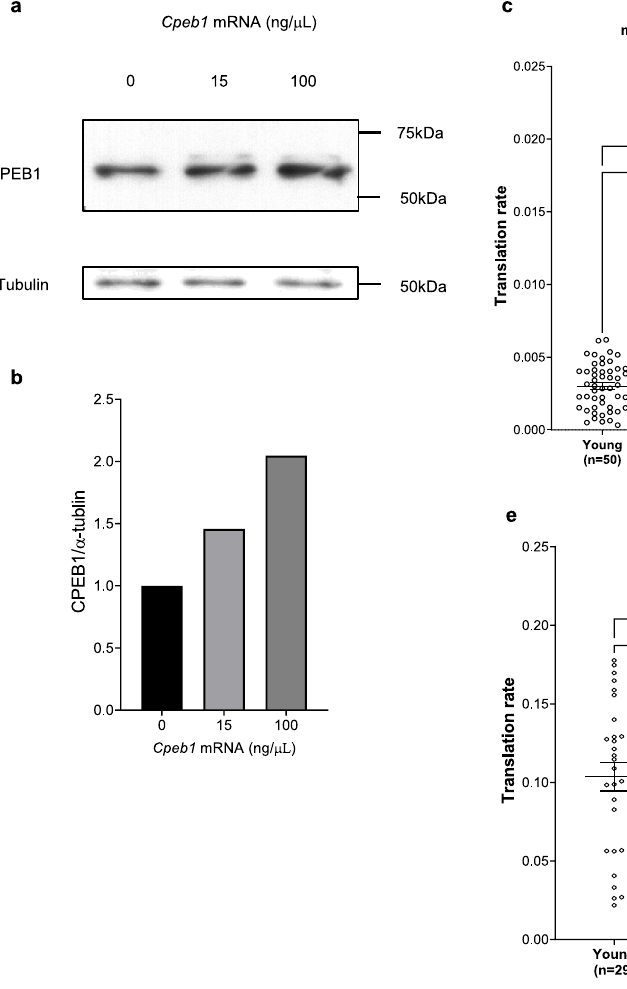
stagewithcilostamidetreatment( c , d ),orreleasedinthecilostamide-freemedium for maturation ( e , f ). YFP and mCherry signals were recorded by time-lapse microscopy every 15min for 20h. The YFP signals were normalized by the level of mCherry signals. The translation rate was calculated for each oocyte by linear regression of the reporter data. Experiments were repeated three times and the data are shown as the mean ± SEM. One-way ANOVA were used to evaluate sta- tistical signi fi cance, ns not signi fi cant, c ** P =0.0076, *** P =0.0002, d * P